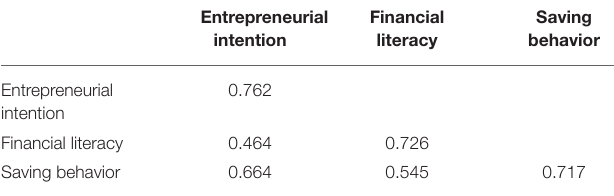
TABLE 4 | Heterotrait–Monotrait ratio (HTMT).